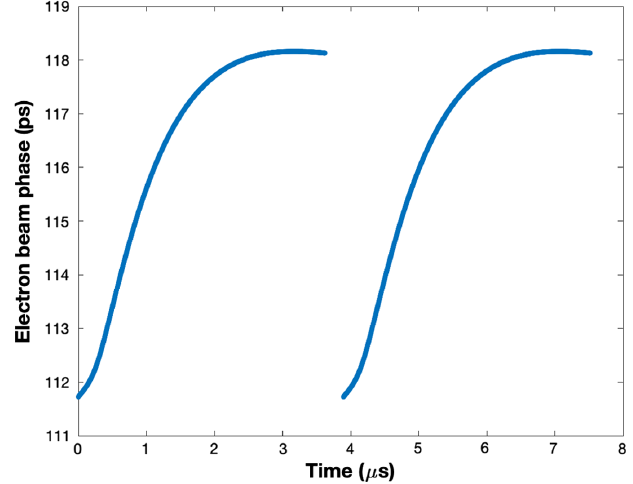
FIG. 1. Block diagram of the topology of the rf and LLRF system studied. FIG. 2. Electron beam synchronous phase transient.